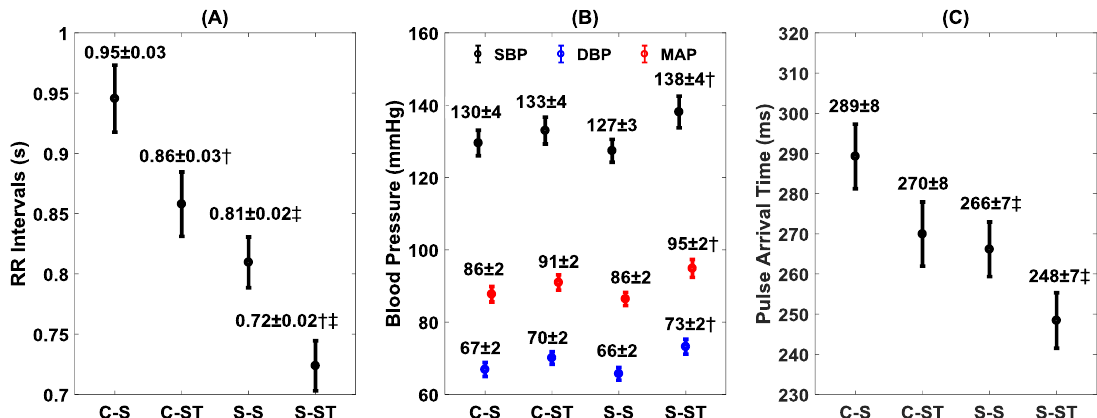
Figure 2. The behavior of RR intervals ( A ), blood pressure ( B ), and PAT ( C ) with group (control/stroke) and condition (sit/stand). The figure presents the distribution (mean ± SE) of control–sit (C–S), control–stand (C–ST), stroke–sit (S–S), and stroke–stand (S–ST). † represents a significant difference from sit (same group), while ‡ represents a significant difference from control (same condition).